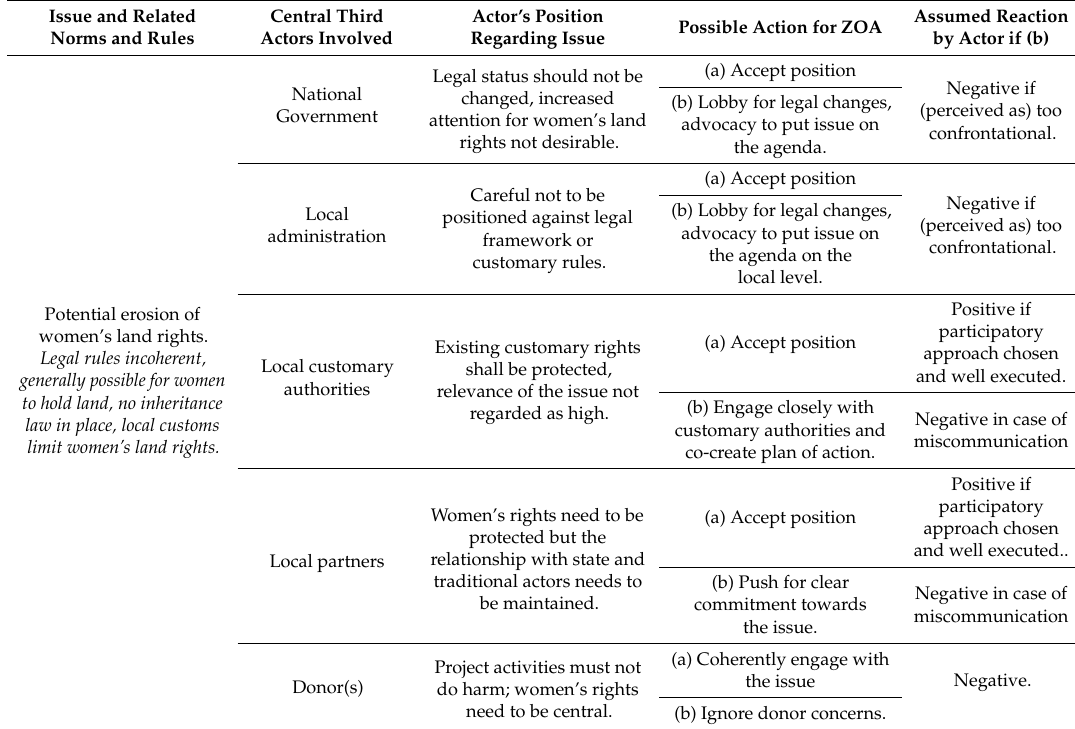
Table 1. Schematic representation of Burundi case: women’s land